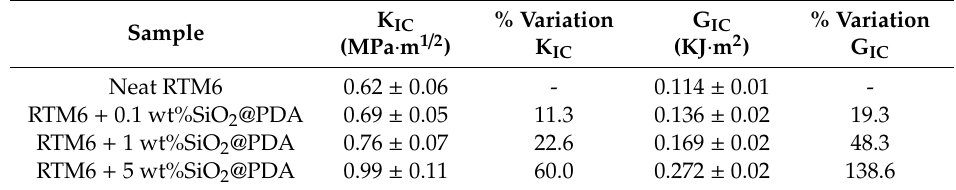
Table 3. Results of fracture toughness tests for neat epoxy and SiO 2 @PDA / RTM6 systems.